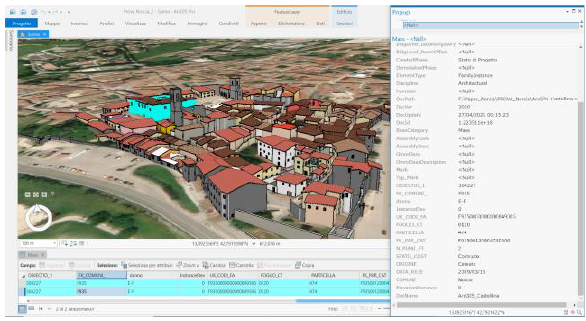
Figure 13. Storage of the geometric and semantic information in a HBIM model visualised in GIS